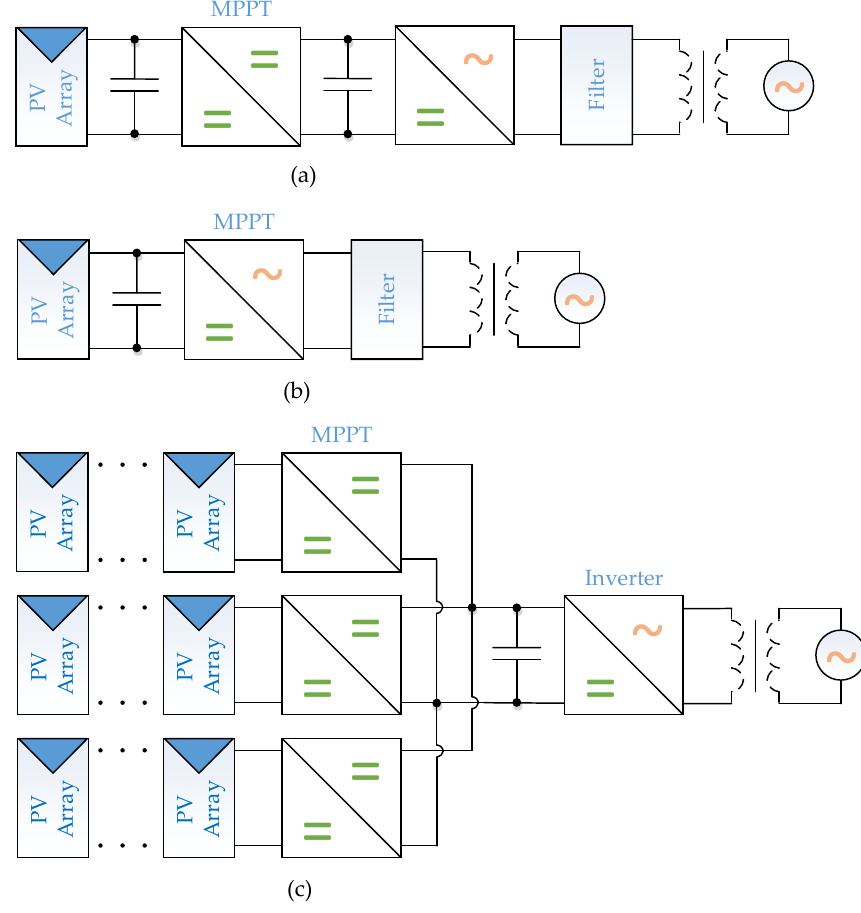
Figure 8. On-grid application structures that are commonly used include: ( a ) two-stage on-grid application; ( b ) single-stage on-grid application; and ( c ) distributed two-stage applications.